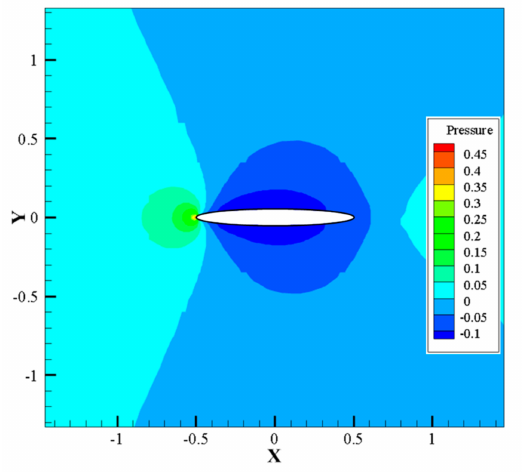
Figure 9. CFD calculation of pressure cloud